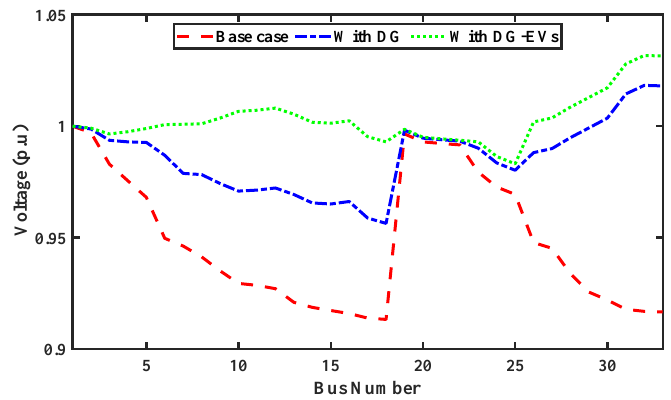
Figure 5. Voltage profile of modified test system.